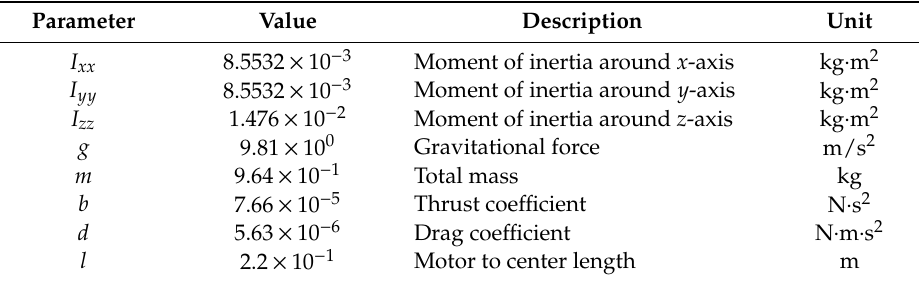
Figure 7. Three quadrotors leader–follower connection topology. Table 2. Quadrotor model parameters.